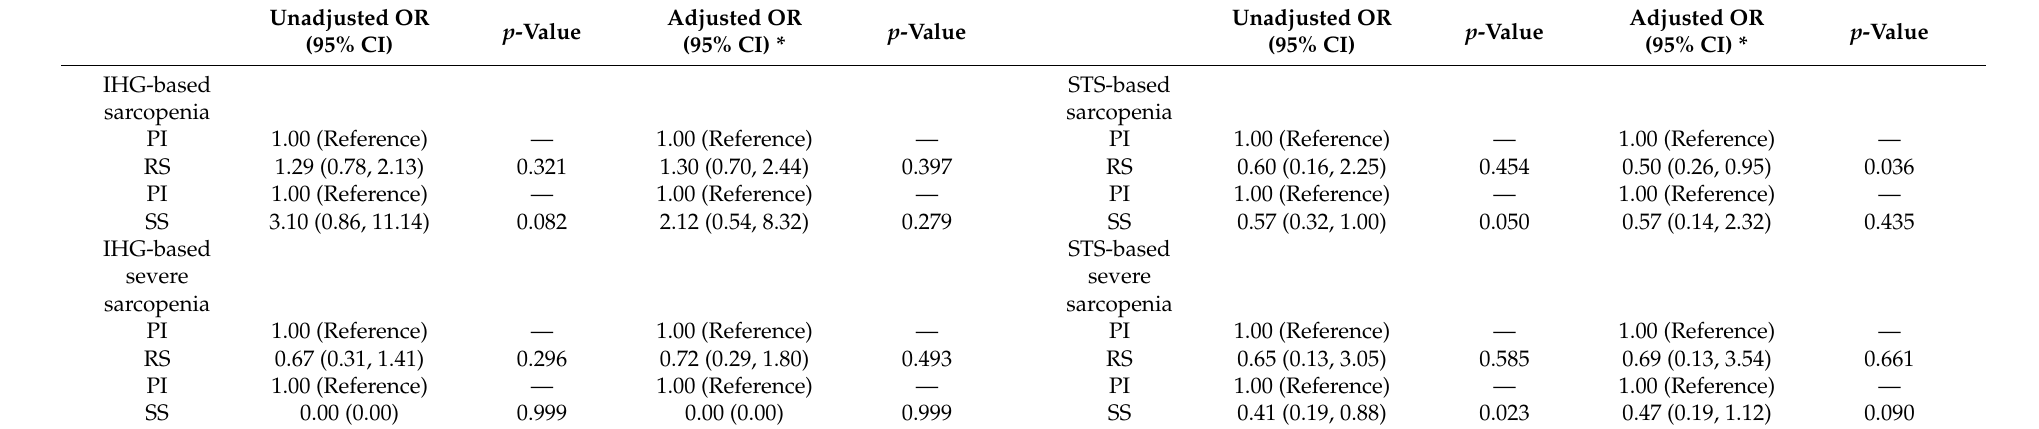
Table 2. Association between training status and sarcopenia in older women ( n = 1814).